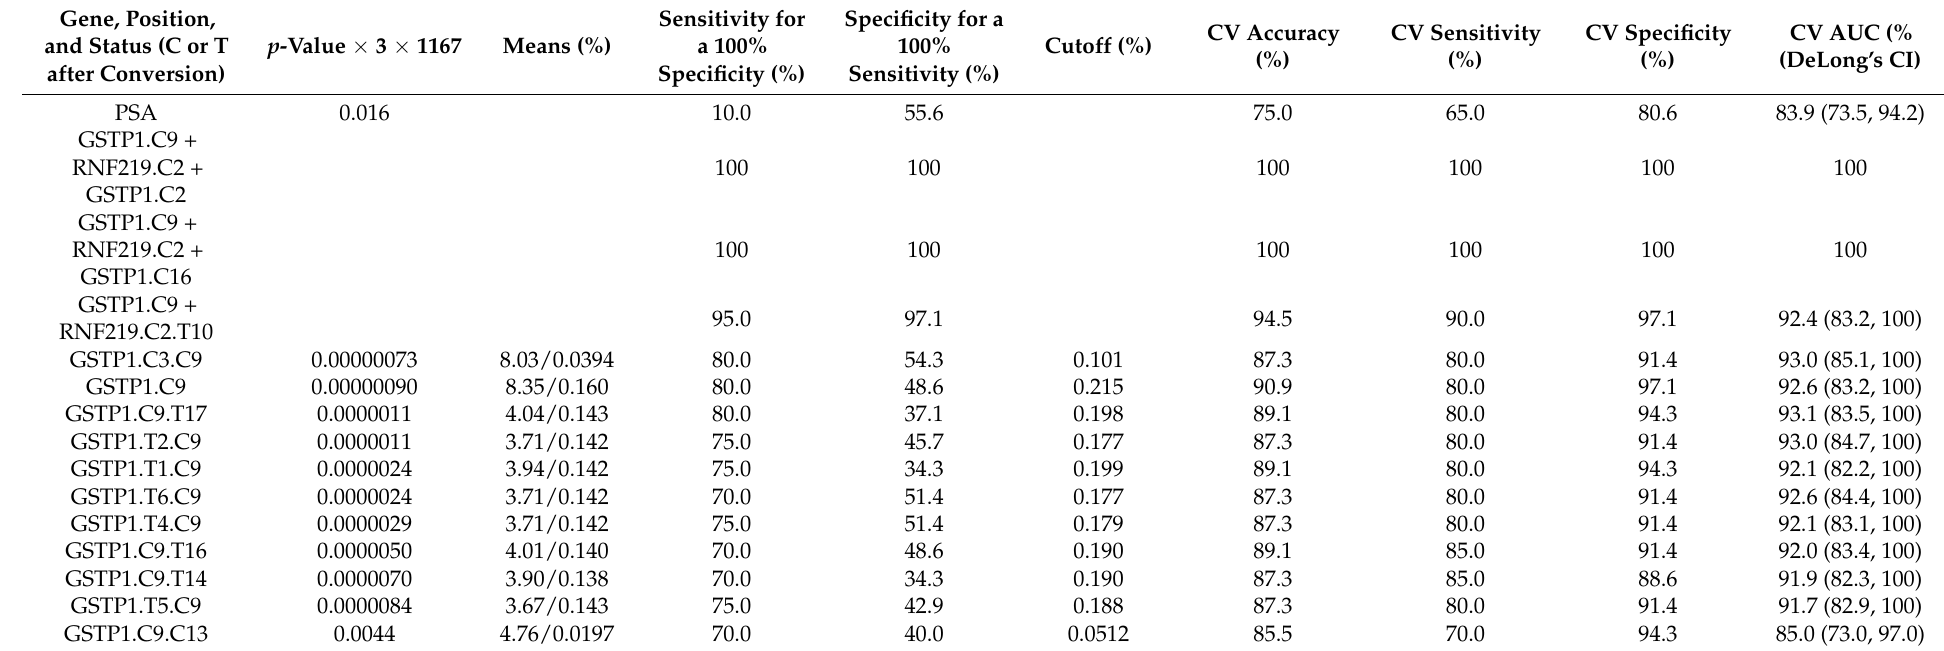
Table 4. Comparison of PCa patients with a joint group including HD and BPH